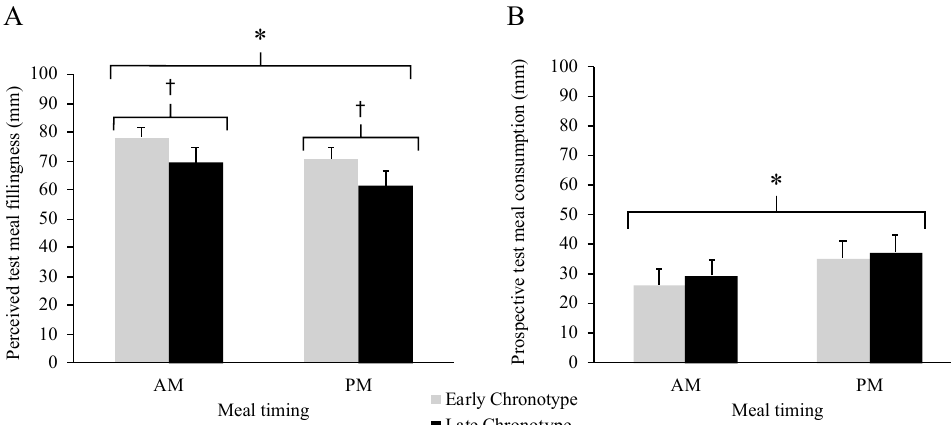
Figure 2. Ratings of perceived test meal fillingness (A) and prospective test meal consumption (B) according to meal timing condition (AM vs. PM) and chronotype (Early vs. Late). * Main effect of meal timing condition, p ≤ 0.017. † Main effect of chronotype group, p = 0.038. N = 41 (Early Chronotype N = 21, Late Chronotype N = 20). Data are mean ± SEM.